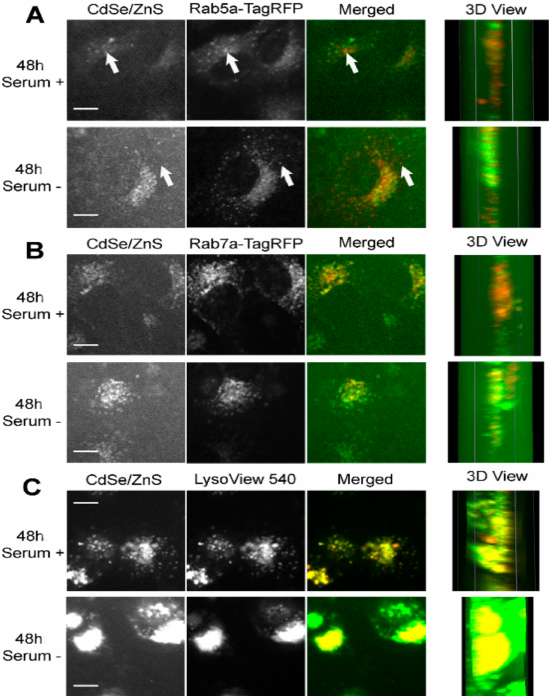
Figure 5. Representative confocal microscope images depicting subcellular localizations of green CdSe/ZnS-COOH QDs after 48 h treatment with QDs in HeLa cell culture. ( A , top ) Partial colocaliza- tion of the early endosome reference marker Rab5a-TagRFP with the QDs in the presence of serum. ( A , bottom ) Partial colocalization of QDs with Rab5a-TagRFP in cells grown in the medium lacking serum. Arrows indicate spatial areas of no colocalization between QDs and Rab5a-TagRFP. ( B , top ) Colocalization of the late endosome reference marker Rab7a-TagRFP with the QDs in the presence of serum. ( B , bottom ) Colocalization of QDs with Rab7a-TagRFP in cells grown in the medium lacking serum. ( C , top ) Colocalization of the lysosome reference marker LysoView 540 with the QDs in the presence of serum. ( C , bottom ) Colocalization of QDs with LysoView 540 in cells grown in the medium lacking serum. Scale bars correspond to 10 µ